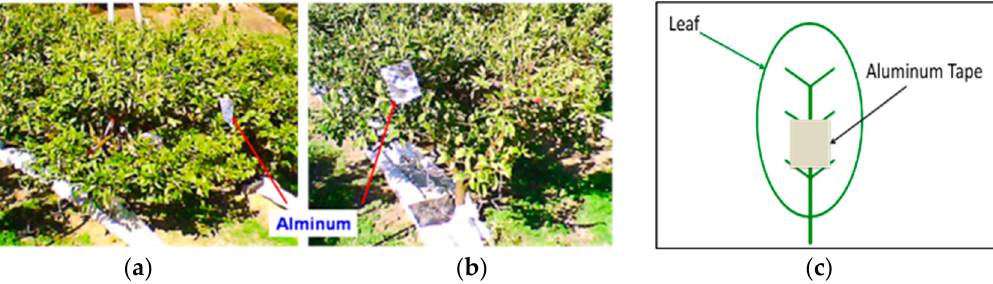
Figure 1. Aluminum as the control point in the field experiment: ( a ) Tree whose vigor strength is good; ( b ) Tree whose vigor strength is bad; ( c ) The usage of aluminum tape.